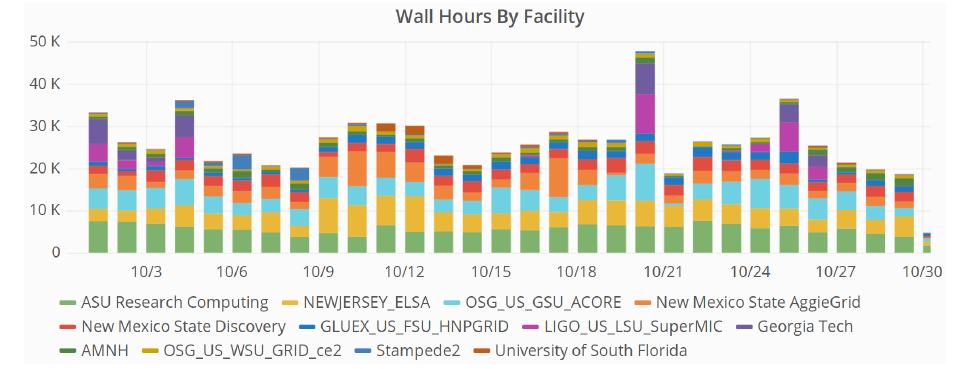
Figure 3. A subset of facilities that are using the Hosted CE initiative to share their